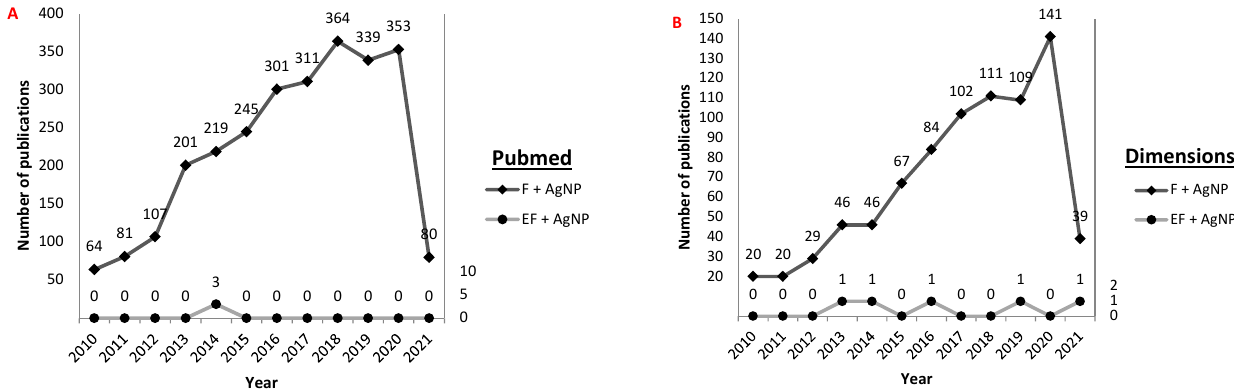
Figure 5. Prospecting the number of publications existing in scientific articles bases between the years 2010 and 2021: ( A ) = Pubmed, ( B ) = Dimensions. Keywords used for title and abstract search: “ fungi and silver nanoparticle ” (F + AgNP), “ entomopathogenic fungi and silver nanoparticle ” (EF + AgNP). The 2021 data refer only to the first three months of that year.